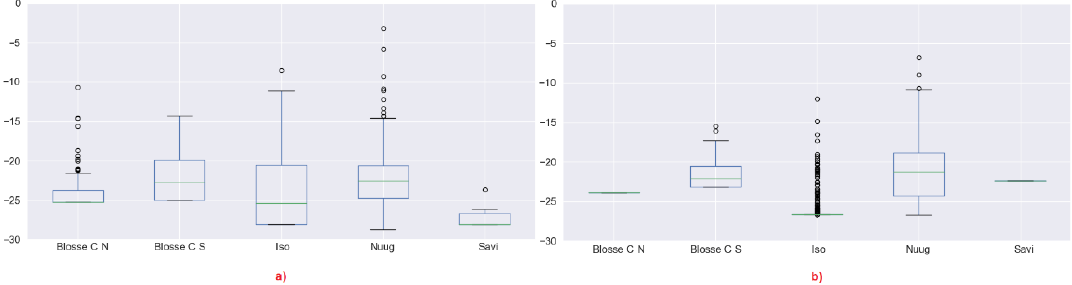
Figure 19. ( a ) Iceberg volume scattering boxplot 5 × 5 window, ( b ) 11 × 11 window. There are significant Figure 19. ( a ) . Iceberg volume scattering boxplot 5 × 5 window, ( b ) 11 × 11 window. There are changes in volume scattering in Isortoq and Figure 19. ( a ) . Iceberg volume scattering boxplot 5 × 5 window, ( b ) 11 × 11 window. There are significant changes in volume scattering in Isortoq and Savissivik. Figure 19. ( a ) . Iceberg volume scattering boxplot 5 × 5 window, ( b ) 11 × 11 window. There are significant changes in volume scattering in Isortoq and Savissivik. significant changes in volume scattering in Isortoq and Savissivik.